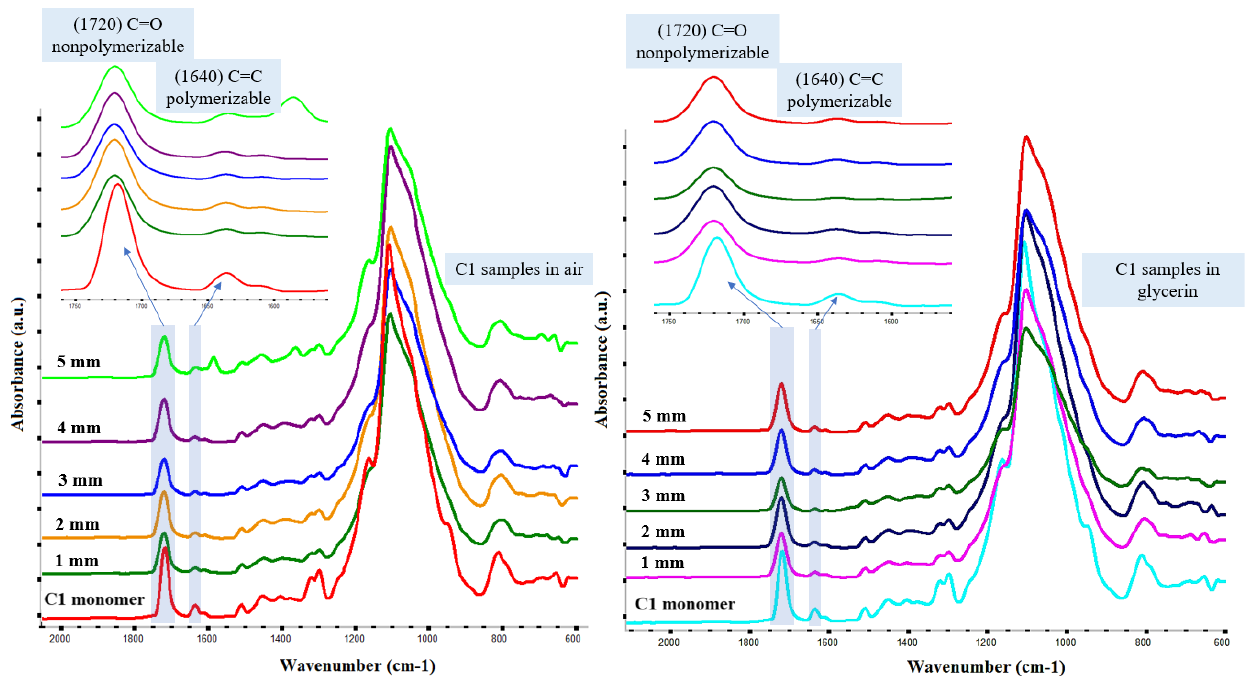
Figure 4. The FT-IR spectra of C1 restorative materials crosslinked in different polymerization en- vironments (air and glycerin, respectively) at various distances from the light curing source. The conversion degree (CD) into polymer network under LED lamp for each material